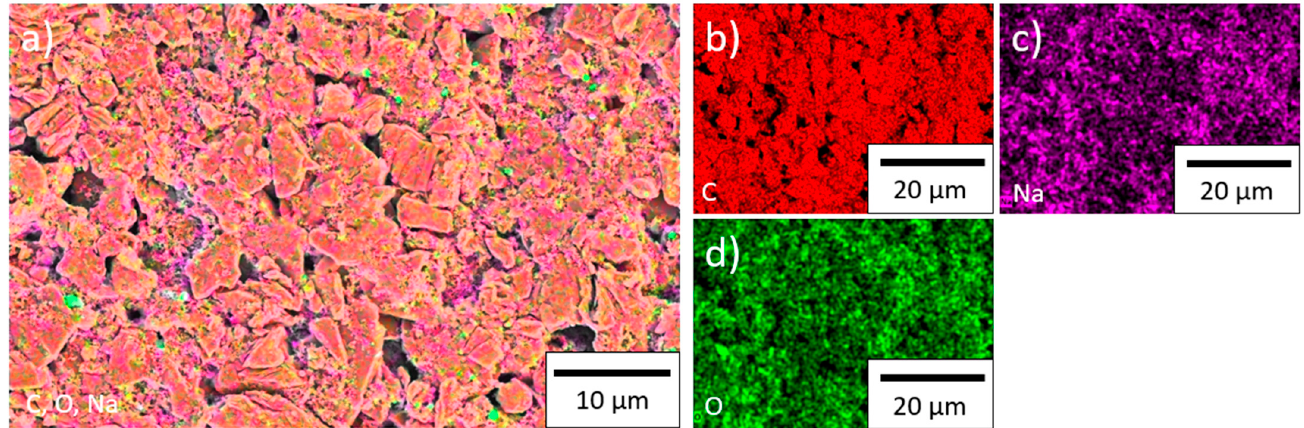
Figure A3. Viscosity of the slurries and the CMC solution for an application-oriented shear-rate range; the used shear-rate of 33.3 1/s is marked with a red line.